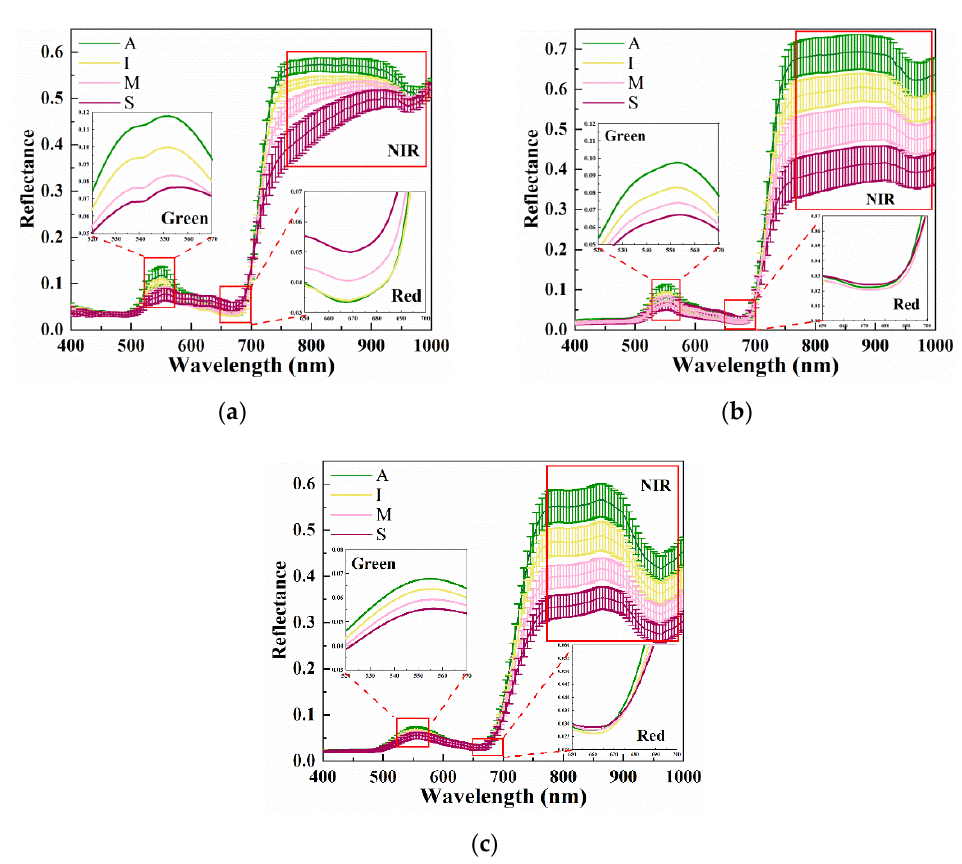
Figure 6. Mean and variance of the reflectance of different disease severity levels at multiple scales. ( a ) Leaf scale, ( b ) plant scale, and ( c ) field scale.